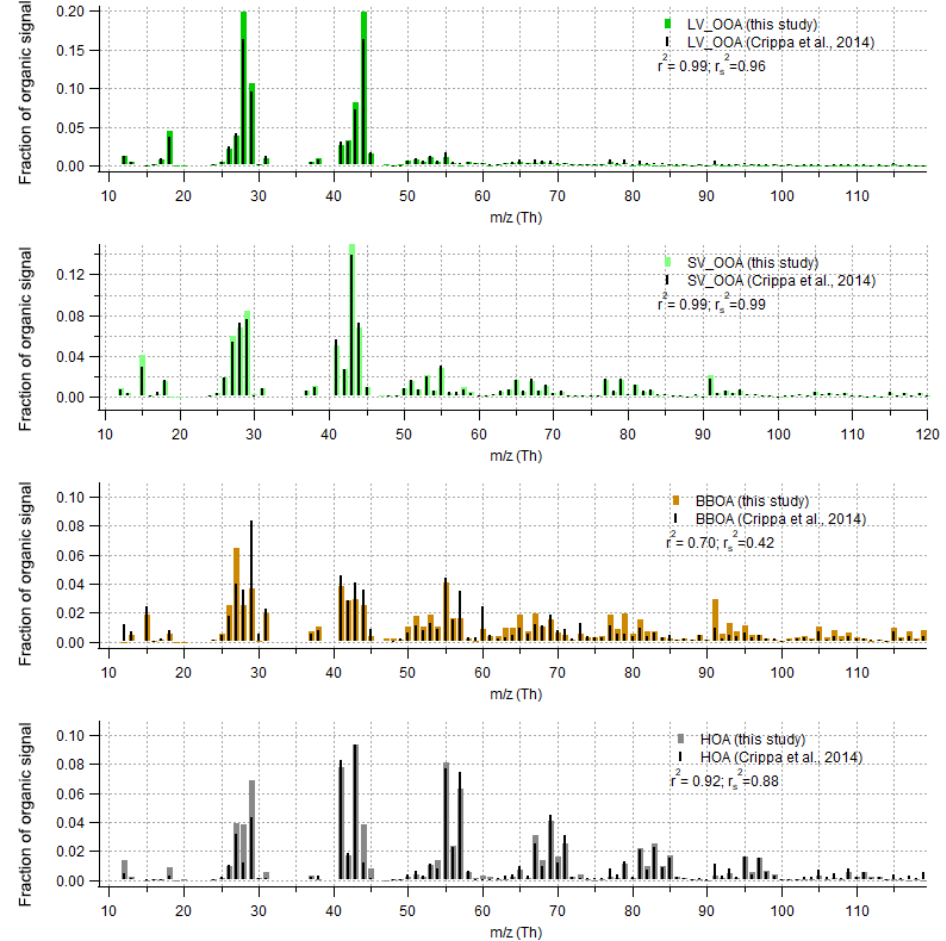
Figure 9. Comparison of organic part of spectra with Crippa et al. (2014) for data set II. The r-CMB model results from this study are shown in colour, and the Crippa et al. (2014) spectra in black. For comparability, the Crippa et al. (2014) spectra were corrected for a difference in fragmentation tables used (included m/z 28 Th, updated to modern calculation of m/z 16, 17 and 18 Th organic signals) and total signal subsequently re-normalised to unity. Spectra similarity is evaluated using Pearson’s squared correlation coefficients: unscaled ( r 2 ) and with mass scaling ( r 2 s